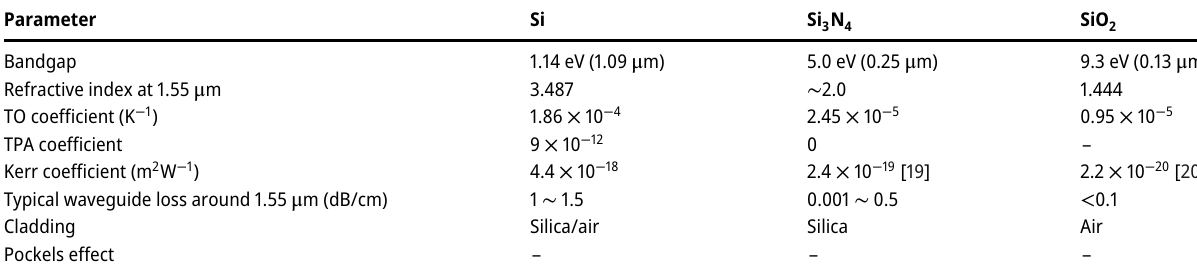
Table 1: Optical properties of the silicon family [14, 15,